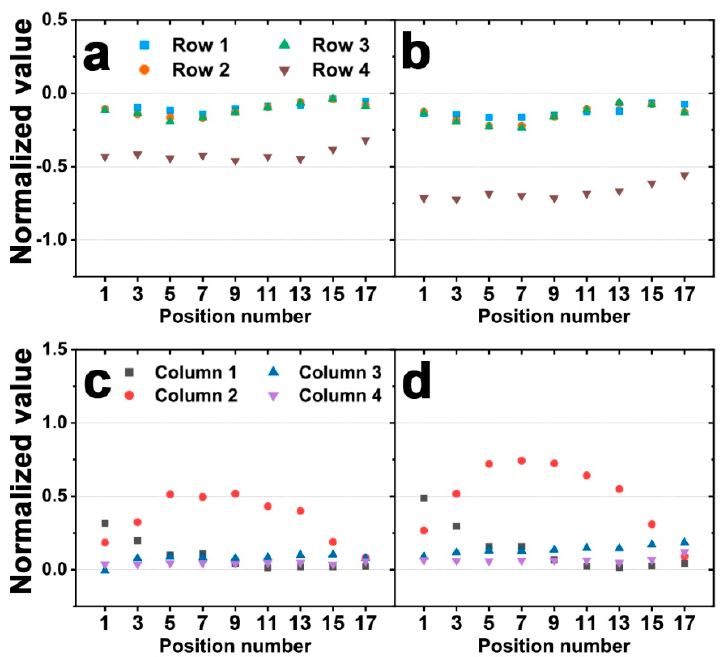
Figure 12. Experimental results of the normalized value from the output voltages of a sensor ( a , c ) when 3 N of force was applied to row 4, and ( b , d ) when 4 N of force was applied to row 4. The graphs above show the response of the row sensors, and the graphs below show the response of the column sensors.